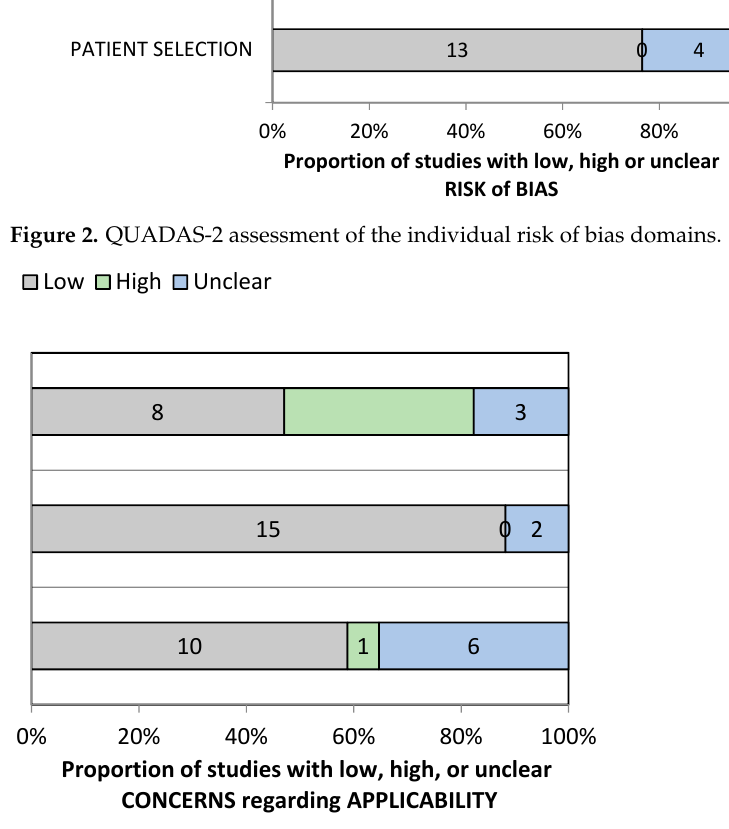
Figure 3. QUADAS-2 assessment of applicability concerns.